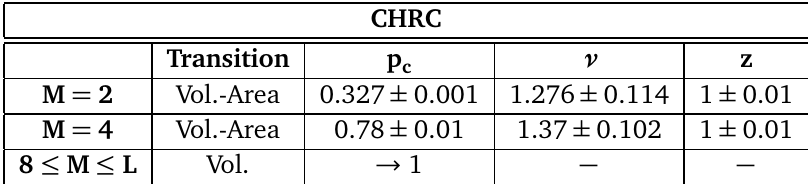
= 0.41 (Left), p = 0.22 (Center), and Figure 12: Dynamical scaling of S for p R c c = 0.16 (Right). The collapse is obtained respectively for z = 0.33 ( 7 ) , z = 0.81 ( 4 ) , p c and z = 0.95 ( 8 ) . Table 1: Summary of the results for the CHRC.